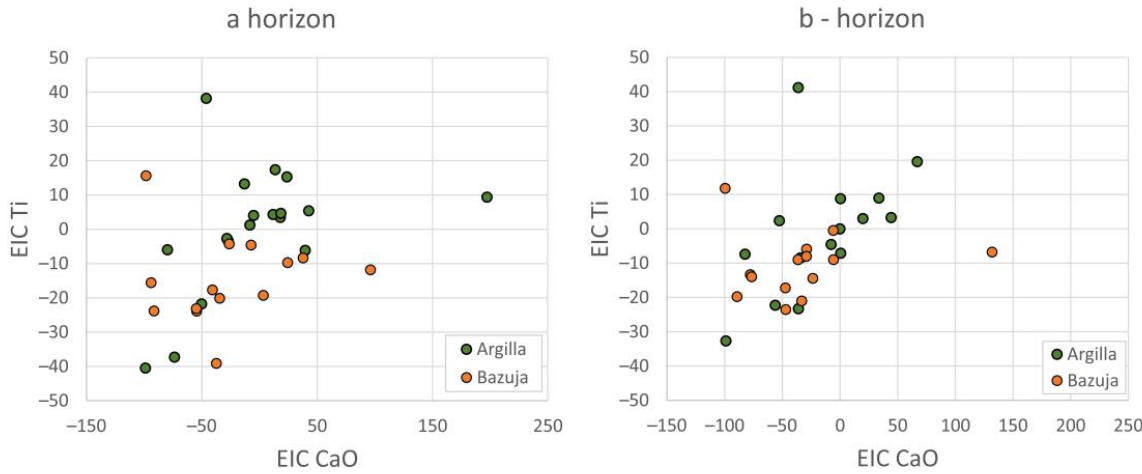
Figure 6. Distribution of calculated EIC CaO compared to EIC Ti in a and b soil horizons in the rivers Argilla and Bazuja’s catchments.